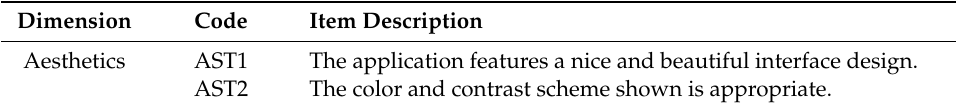
Table 1. The Aesthetics dimension and its items.